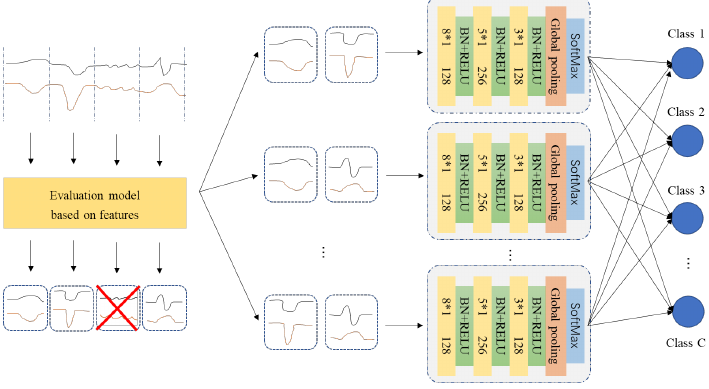
Figure 1. The overall structure of